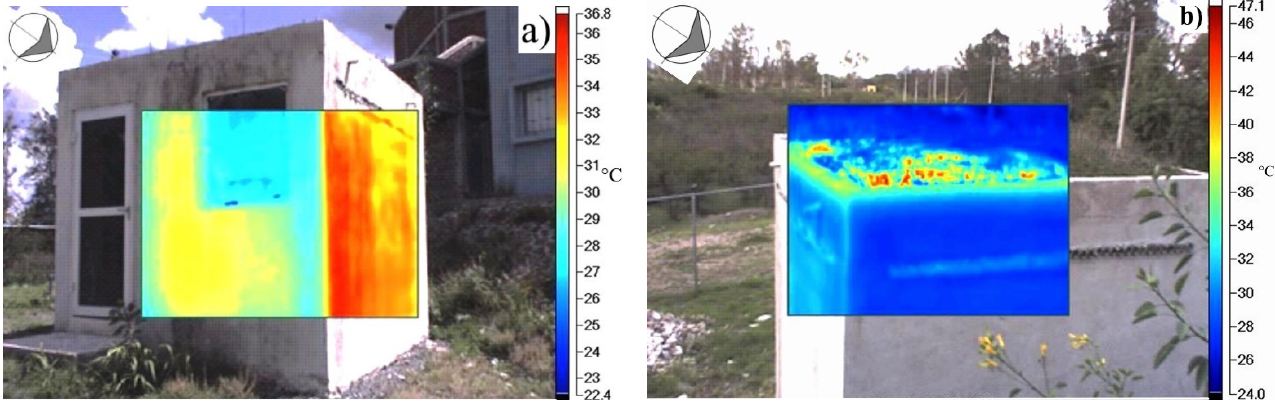
Figure 8. Thermography images of the finished prototype room (taken at 15:45): ( a ) Façade view showing a temperature range of 22.4–36.8 °C; ( b ) top view showing the roof with endemic plants and a temperature range of 24.0–47.1 °C.